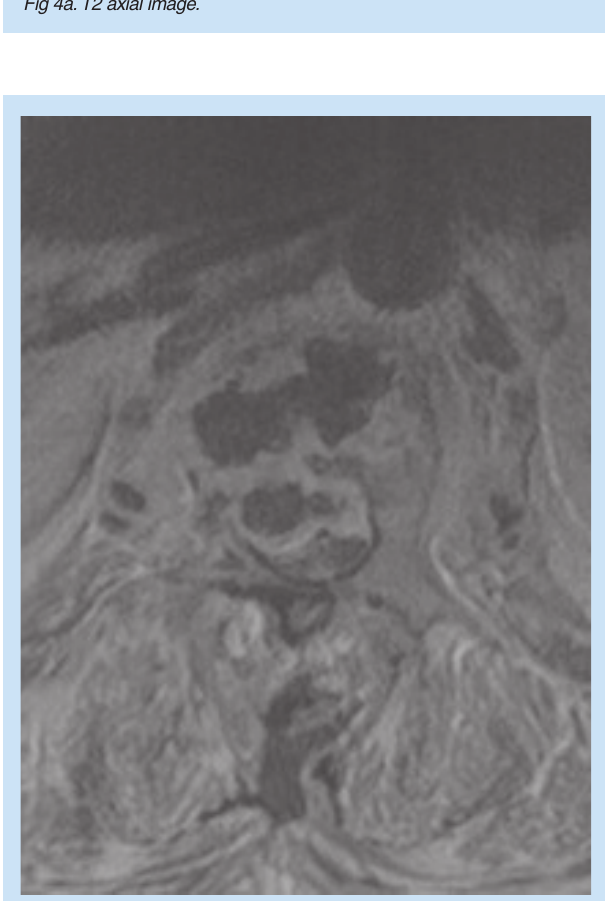
Fig 4b. T1 postcontrast axial image. Demonstrating thick irregular paraver- tebral abscess